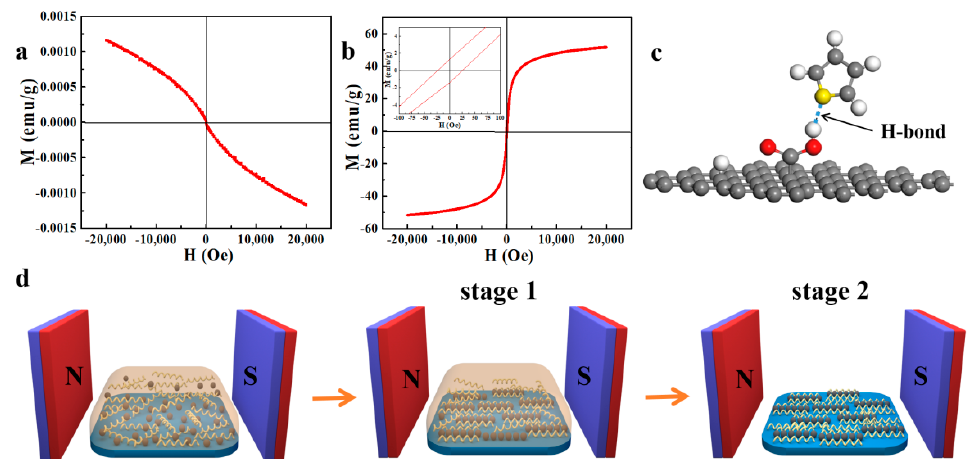
Figure 5. Magnetization versus magnetic field (M-H) curves at room temperature (25 °C) of PBTTT ( a ) and Fe 3 O 4 @C ( b ); the inset in ( b ) is the corresponding part of the hysteresis curve (field from − 100 to 100 Oe). ( c ) Interaction mode of thiophene with the carboxyl groups on the surface of the Fe 3 O 4 @C. The atoms are colored as white (H), gray (C), red (O), and yellow (S). ( d ) Schematic illustration of the magnetic alignment process of the as-deposited Fe 3 O 4 @C/PBTTT composite film on the sub- strate.